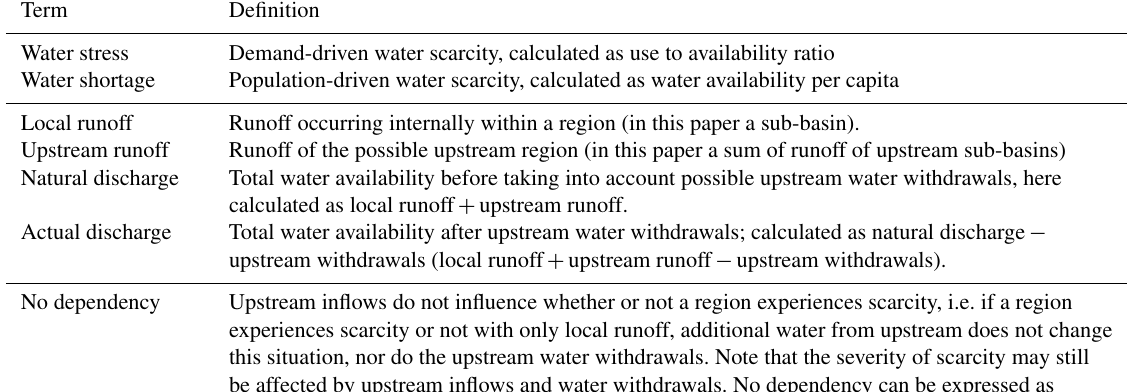
Table 1. Key terminology used in the analysis and their definitions. Note: definitions in terms of water availability volumes emerge from our analysis, as described in Sect. 2 and summarised visually in Fig. 4. Our analysis method did not consider the case where actual discharge may be greater than natural